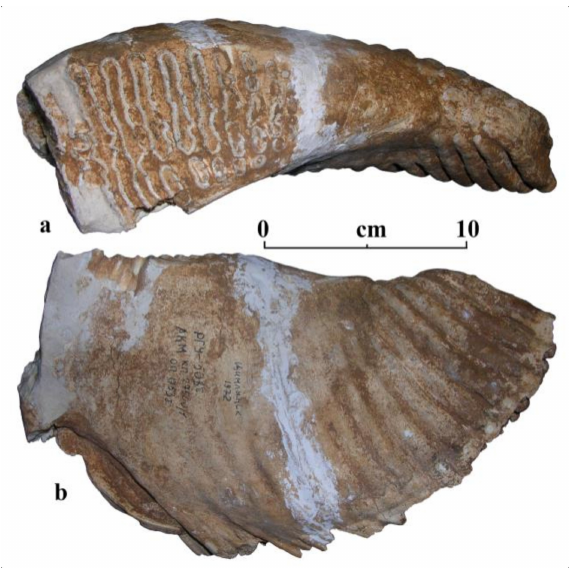
Figure 7. Tooth of mammoth Mammuthus intermedius from Tsymlyansk (Rostov Region, Russia; the late Middle—early Late Pleistocene): ( a , b )—AMZ KP-27500/1, left m3, occlusal surface, buccal view. The Lower Don River fluvial deposits. Isolated upper M3 and lower m2 from the collection of NMDC. An isolated lower m2 from the collection of AVIM. An isolated heavily worn left m3 from the collection of ROMK. The color of the dentine is from light- to dark-brown, and the enamel is